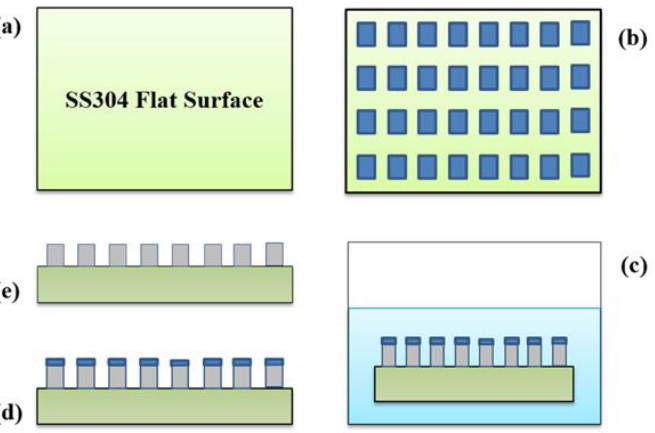
Figure 2. Fabrication of micropillars on SS304 flat surface using a chemical etching method. ( a ) SS304 flat surface, ( b ) square micropattern design engraved on the photoresist coated on the flat surface, ( c ) flat surface with photomask dipped in an etchant solution, ( d ) micropillars on top of the flat surface, and ( e ) micropillars upon removal of photomask.